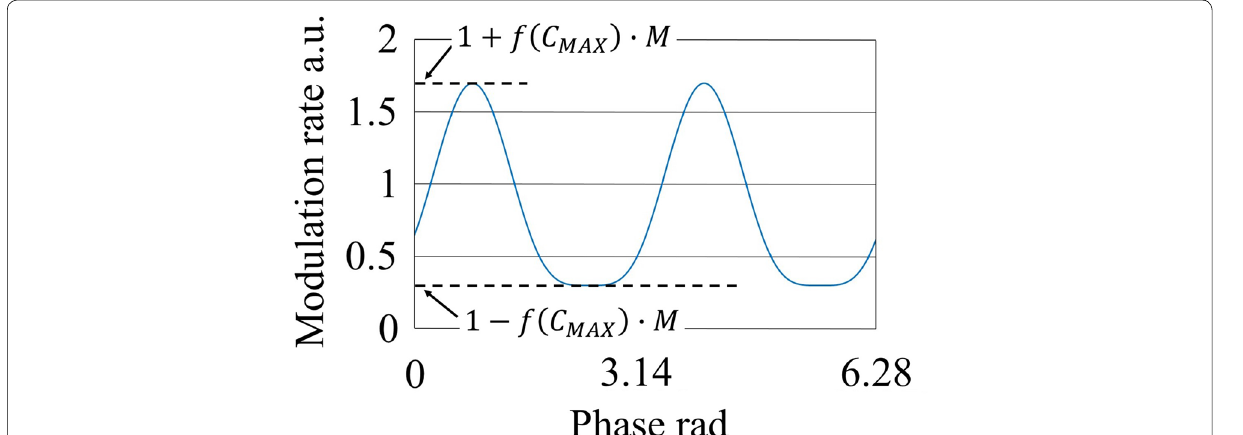
Fig. 5 Example of the variation of modulation strength N D against the variation of